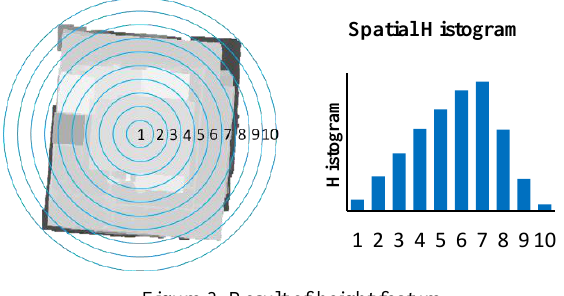
Figure 3. Result of height feature. 2.2.2 Line Feature: To extract line features of the